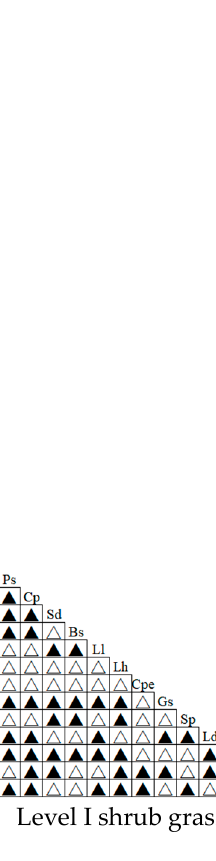
Figure 5. Half-matrix diagram of the χ 2 test of different shrub-level sites. Aa: Anemarrhena aspho- deloides ; Af: Artemisia frigida ; As: Artemisia sacrorum ; Asi: Achnatherum sibiricum ; Asc: Artemisia sco- paria ; Bs: Bupleurum scorzonerifolium ; Ca: Carex appendiculata ; Cc: Corispermum chinganicum ; Ce: